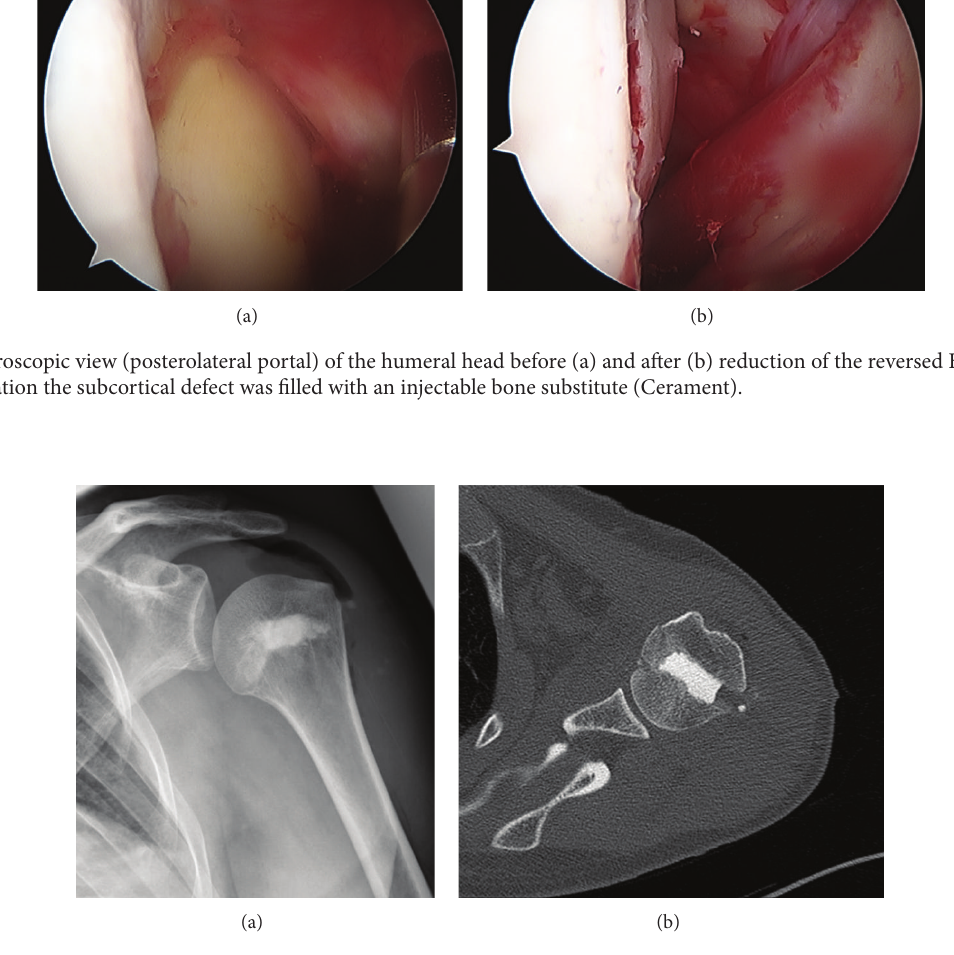
Figure 5: X-ray (a) and CT (b) two days after index procedure showing an intact glenohumeral articulation and a restored humeral head.